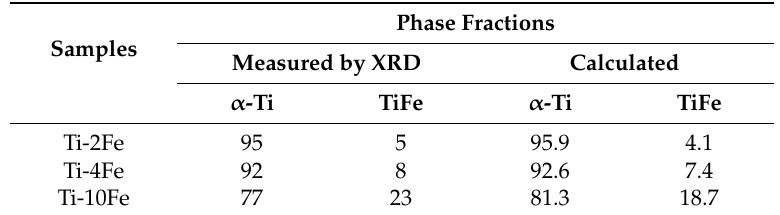
Figure 1. Initial microstructures of samples Ti-2Fe ( a ), Ti-4Fe ( b ), and Ti-10Fe ( c ) annealed at 470 °C for 4000 h. The white grains belong to TiFe, the gray areas to α -Ti. Table 1. Comparison of the phase fractions in the samples annealed at 470 °C for 4000 h, which were determined from the X-ray diffraction (XRD) measurements and calculated using the thermodynamic description of the binary Ti–Fe system by application of the lever rule. All of the phase amounts are given in wt.%. The uncertainty of the XRD phase analysis utilizing Rietveld refinement falls generally within a range of 1 % to 3 %.